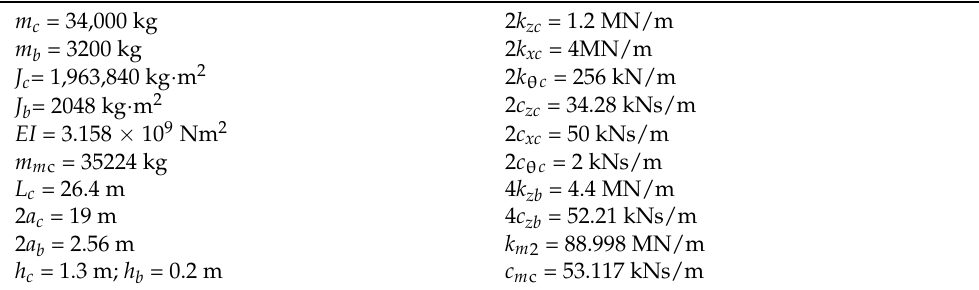
Table 4. Reference parameters of the vehicle